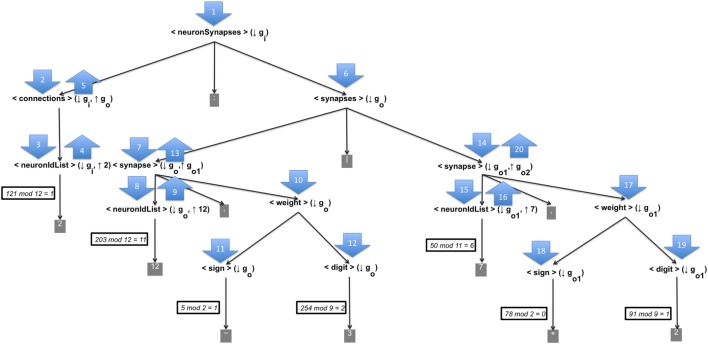
Example of a derivation tree by the CGE’s mapping process. For the input numeric string [121, 203, 5, 254, 50, 78, 91, 17, 31] the CGE’s mapping procees generates the word 2:12, −3|7, +2.